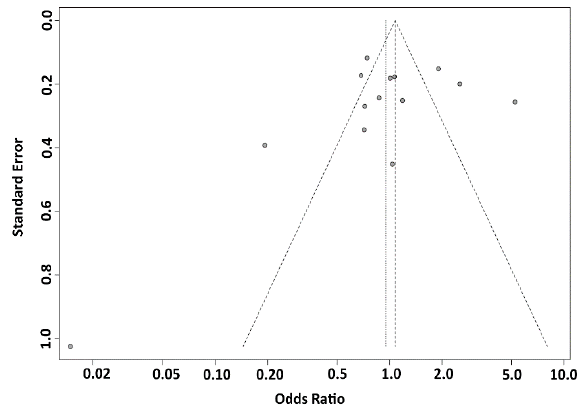
Figure 4 . Funnel plot for publication bias test of the AGT M235T polymorphism and